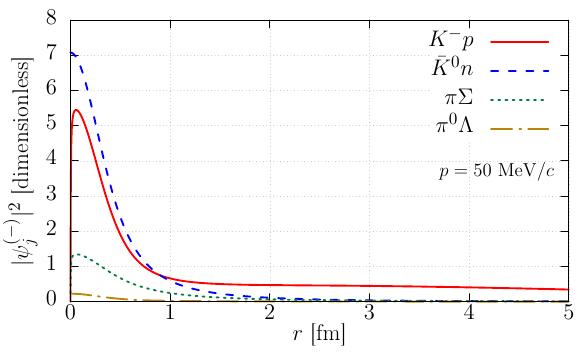
Figure 1. The square of each component of the coupled-channel wave function with q = 50 MeV (thin lines) and 100 MeV (thick lines). The solid, dashed, dotted, and dash-dotted line denote the K − p , ¯ K 0 n , π Σ , and π 0 Λ component. For the π Σ component, we show the sum of three components of π − Σ + , π 0 Σ 0 , and π + Σ − .